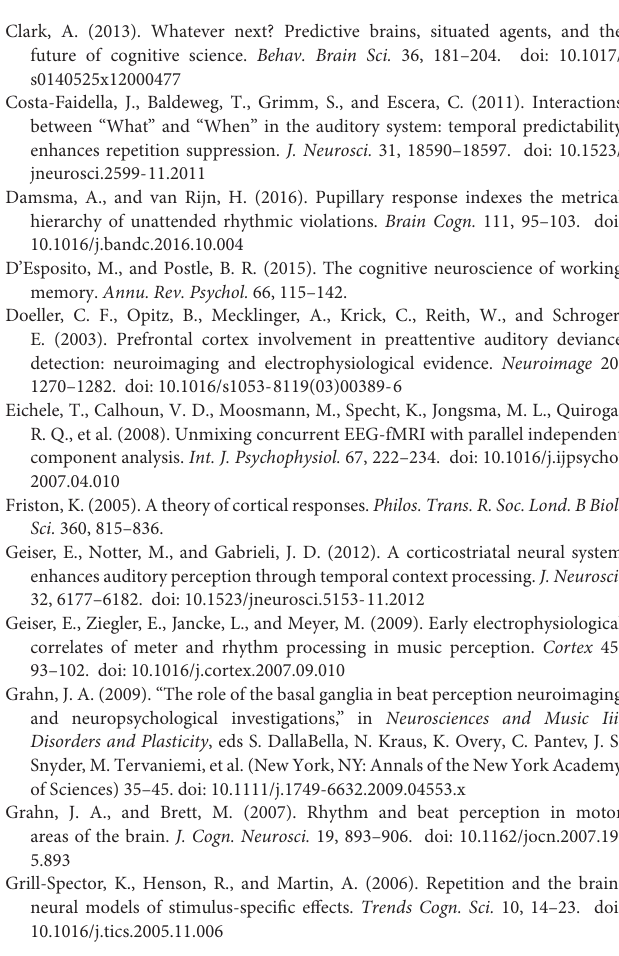
Supplementary Figure 1 | Visualization of findings in Supplementary Table 1 . Supplementary Table 1 | Omission Position 1 > Position 2 across rhythms. Results reported as t -tests uncorrected at p < 0.001, cluster size of 100 voxels. ACC, anterior cingulate cortex; MPFC, medial prefrontal